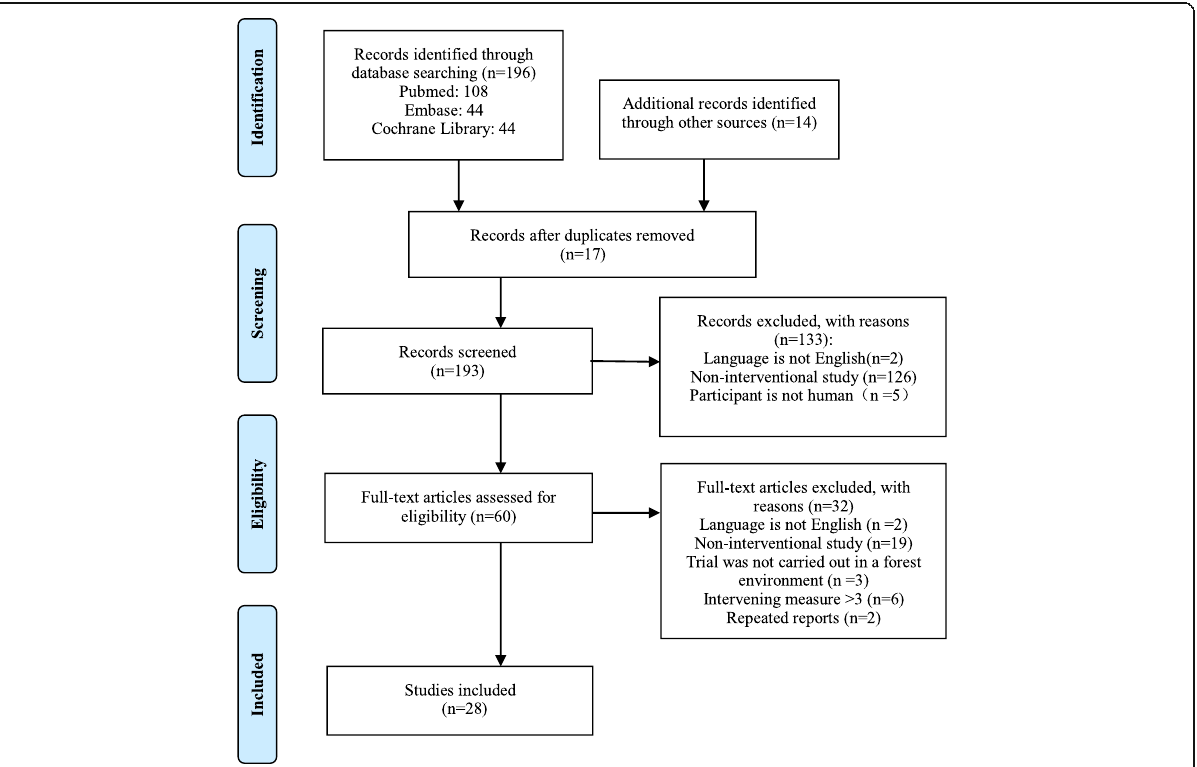
Fig. 1 Flow diagram of the screening